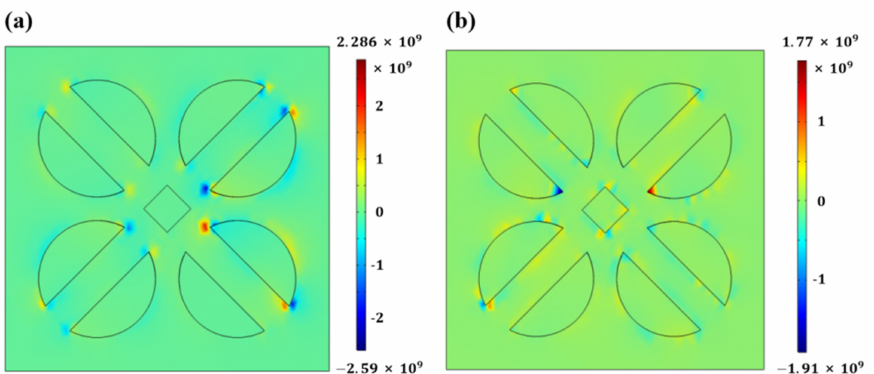
Figure 5. ( a ) Electric field distribution at the absorption peak of f 2 (Ez). ( b ) Electric field distribution at the absorption peak of f 3